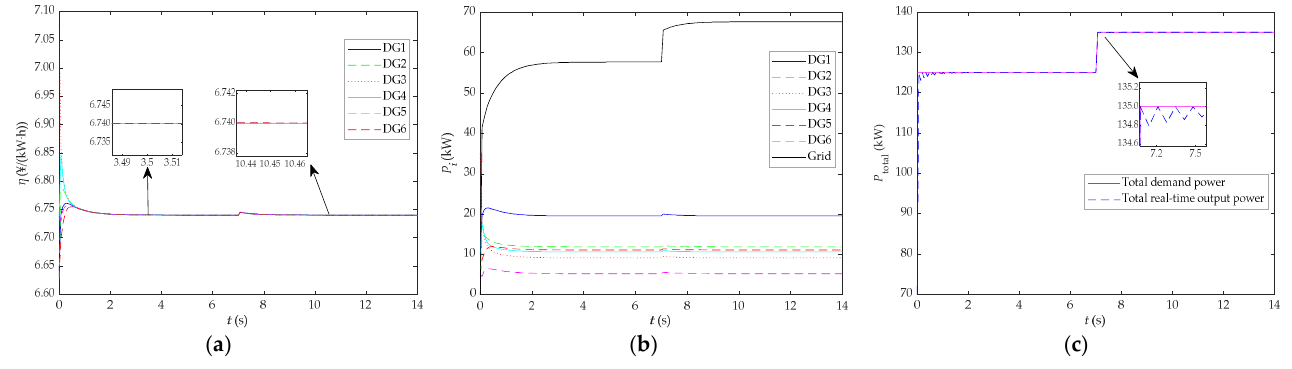
Figure 8. The change curves of variables of the system under variable load condition: ( a ) change curves of each DG’s ICR; ( b ) change curves of each DG’s active output and grid output power; ( c ) change curves of the cumulative sum of each DG’s active output and grid output power as well as total demand power.